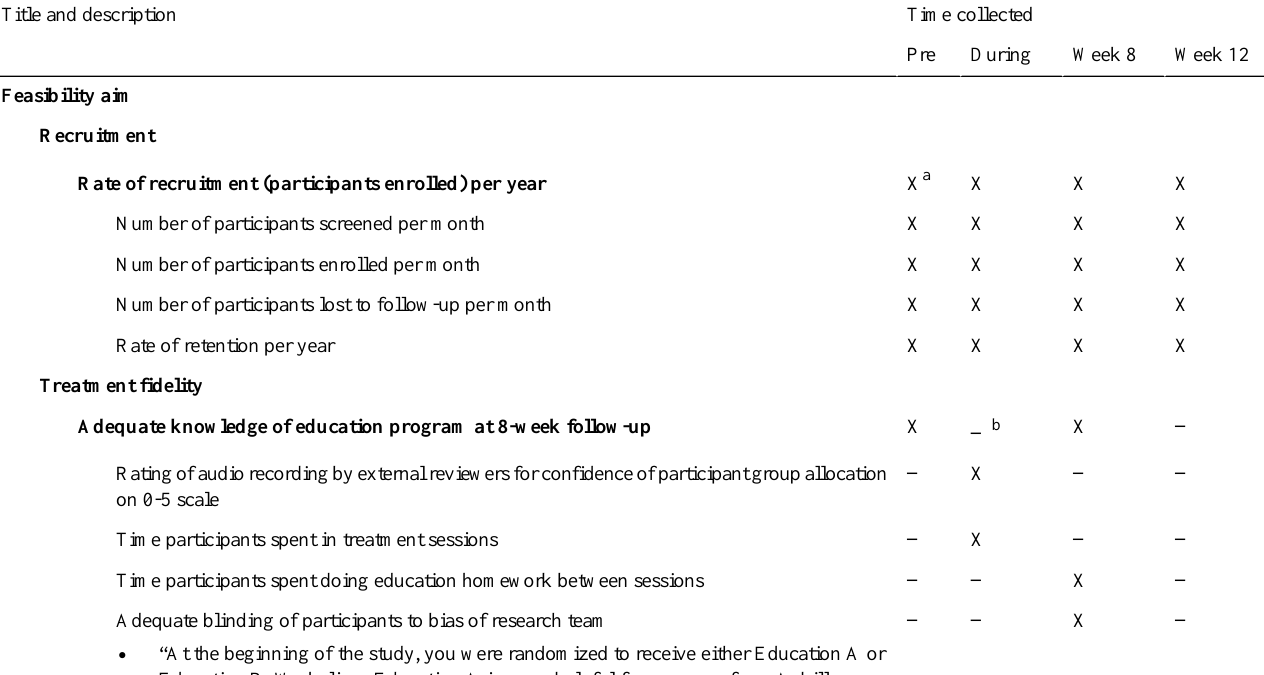
Table 4. For exploratory aim 1, the primary outcomes include primary outcomes for specific aim 1 and treatment fidelity. For exploratory aim 2, the primary outcomes include primary outcomes for specific aim 1 and specific aim